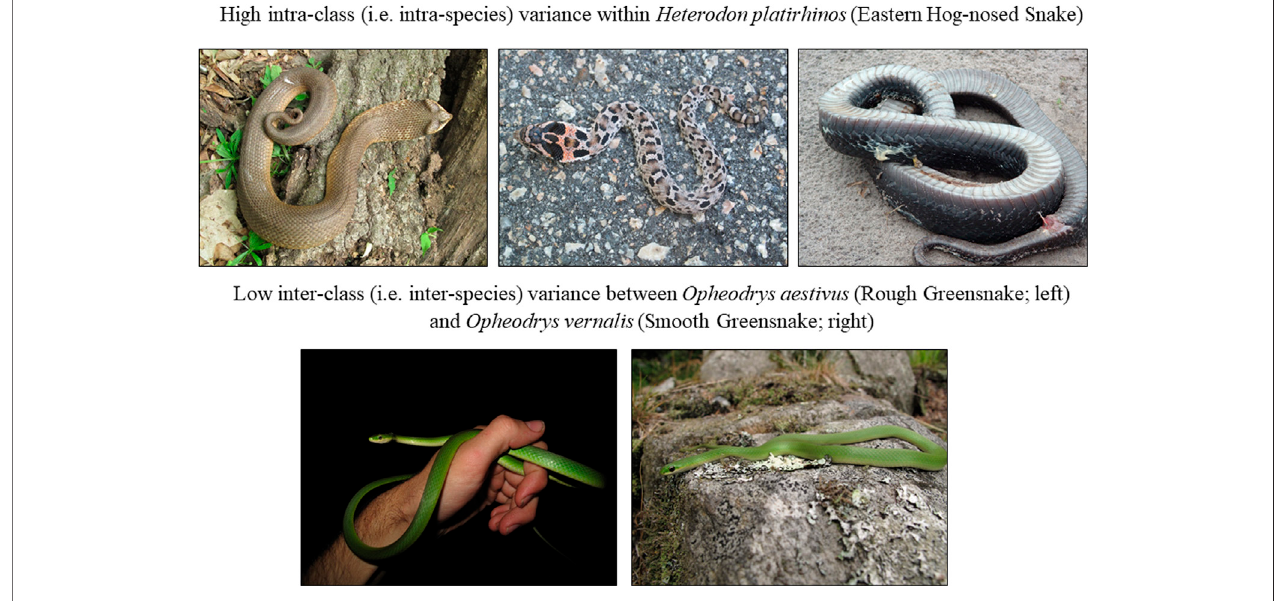
FIGURE 1 | Examples of high intra-class (i.e., intra-species) and low inter-class (i.e., inter-species) variance among snake images. All photos by Andrew M. Durso (CC-BY).